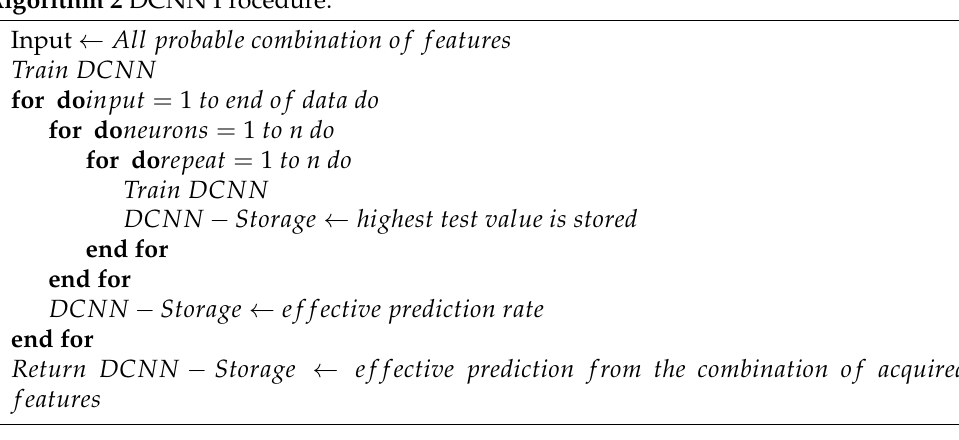
Algorithm 2 DCNN